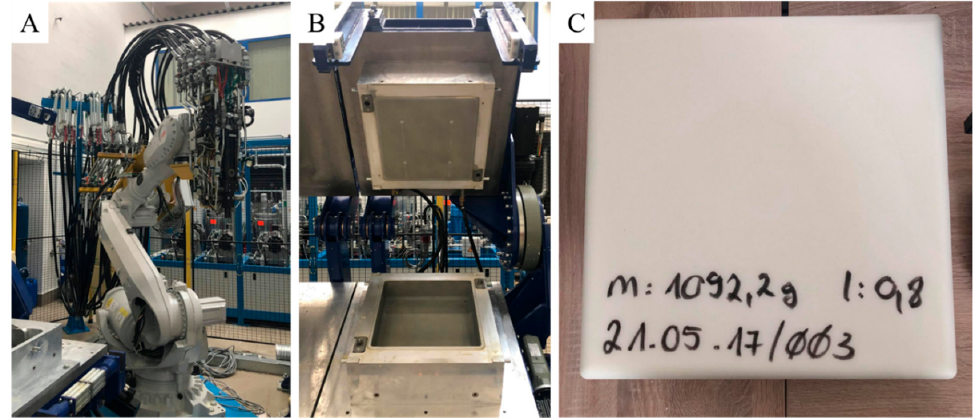
Figure 1. Robotic arm for the injection of polyurethane (PU) components ( A ), mold ( B ), and the